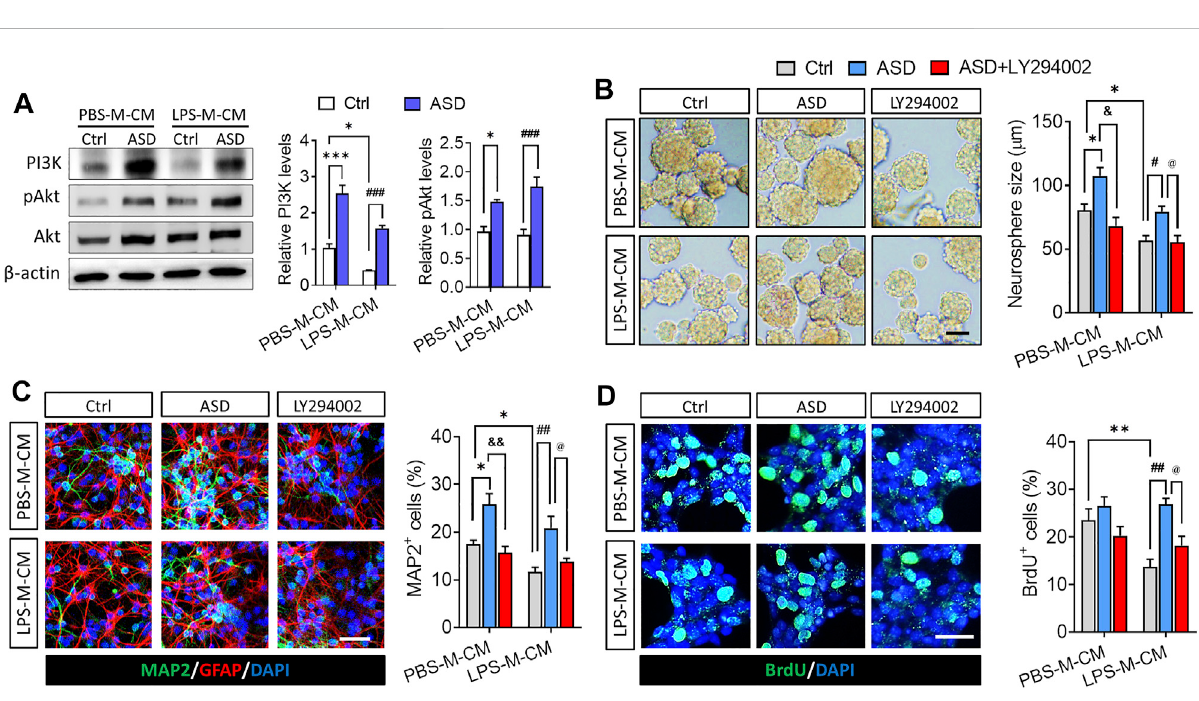
FIGURE 2 ASD protects NSPCs from the microglia-mediated in fl ammatory niche by activating the PI3K-AKT pathway. (A) , Western blotting showing activationofthePI3K-AKTpathwayinNSPCsafterASDtreatment(100 μ M)inthepresenceofPBS-M-CMorLPS-M-CM.LevelsofPI3KandAKTwere normalizedto thoseof β -actin,andlevelsofphospho-AKT (p-AKT)werenormalizedtothoseofAKT.Ctrl,control without ASD. (B) ,Micrographs and quanti fi cation of neurosphere size, showing that the PI3K-AKT pathway inhibitor LY294002 blocked the effects of ASD on neurosphere proliferation in the presence of PBS-M-CM or LPS-M-CM. Scale bar, 100 μ m. (C) , Micrographs and quanti fi cation of the percentage of MAP2+ cells, showing that LY294002 also blocked theeffects ofASD on neurogenesis in thepresence of PBS-M-CMorLPS-M-CM. Astrocytes were labeled with antibodyagainstGFAP(green);neurons,withantibodyagainstMAP2(red).Scalebar,50 μ m. (D) ,Micrographsandquanti fi cationofthepercentageof BrdU + cells, showing that LY294002 blocked theeffects of ASD on NSPC survival in thepresence of LPS-M-CM. Surviving NSPCs werelabeled with BrdU (green). Scale bar, 20 μ m. Results for each group were averaged from 5 micrographs (40×) from each of 4-6 slides. Data are mean ± standard error of the mean (SEM), * p < 0.05, ** p < 0.01, *** p < 0.001 vs. control microglia conditioned medium (PBS-M-CM), # p < 0.05, ## p < 0.01, ### p < 0.001vs.LPS-treatedmicrogliaconditionedmedium(LPS-M-CM),& p < 0.05,&& p < 0.01vs.ASD+PBS-treatedmicrogliaconditionedmedium(ASD + PBS-M-CM), @ p < 0.05 vs. ASD + LPS-treated microglia conditioned medium (ASD + LPS-M-CM) by two-way ANOVA with Tukey ’ s multiple- comparisons